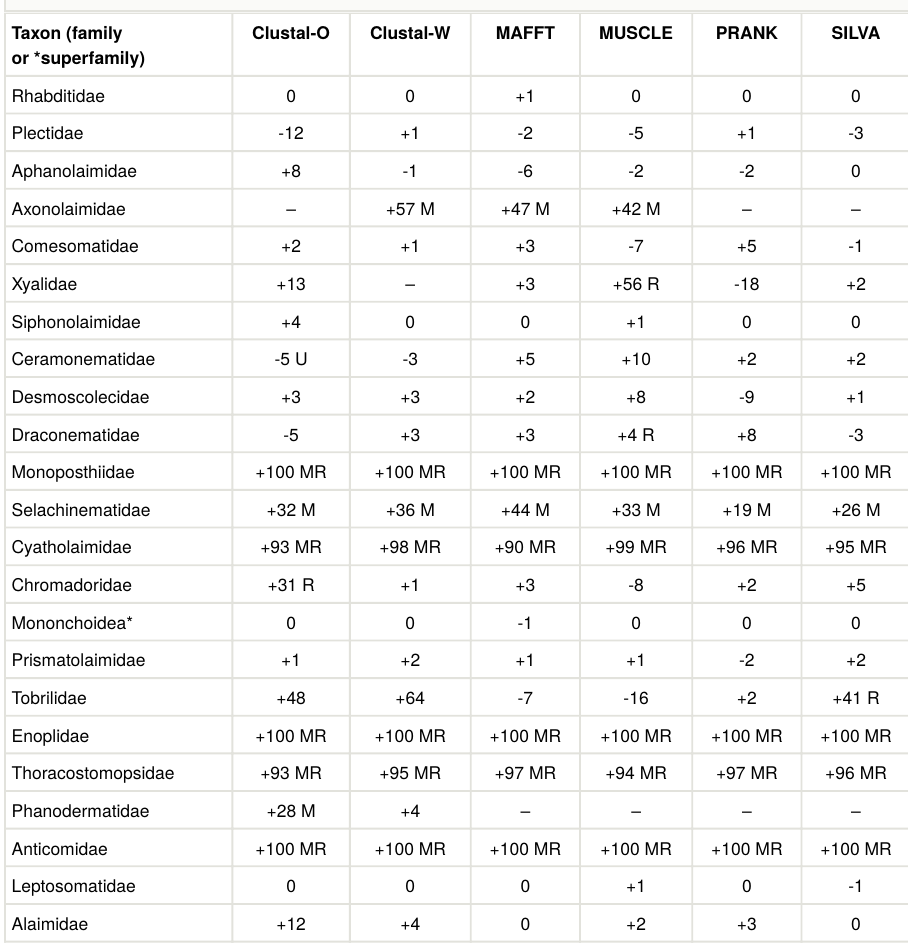
Comparison of changes in bootstrap support (increase or decrease) and resolution for di ff erent nematode families between Neighbor joining analyses of complete and " fi ltered" datasets. Legend: "M" – clade changed from paraphyletic or polyphyletic to monophyletic; "P" – clade changed from monophyletic to paraphyletic or polyphyletic; "–" – clade remained paraphyletic or polyphyletic; "R" – monophyletic clade became fully resolved (bootstrap increased to ≥ 70%); "U" – monophyletic clade became unresolved (bootstrap decreased to